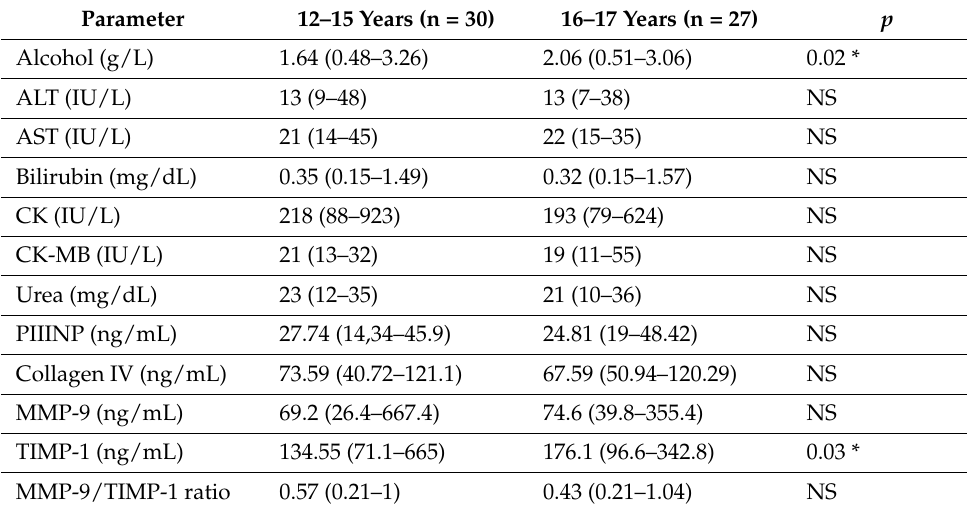
Table 2. Characteristics of the study group in terms of age.